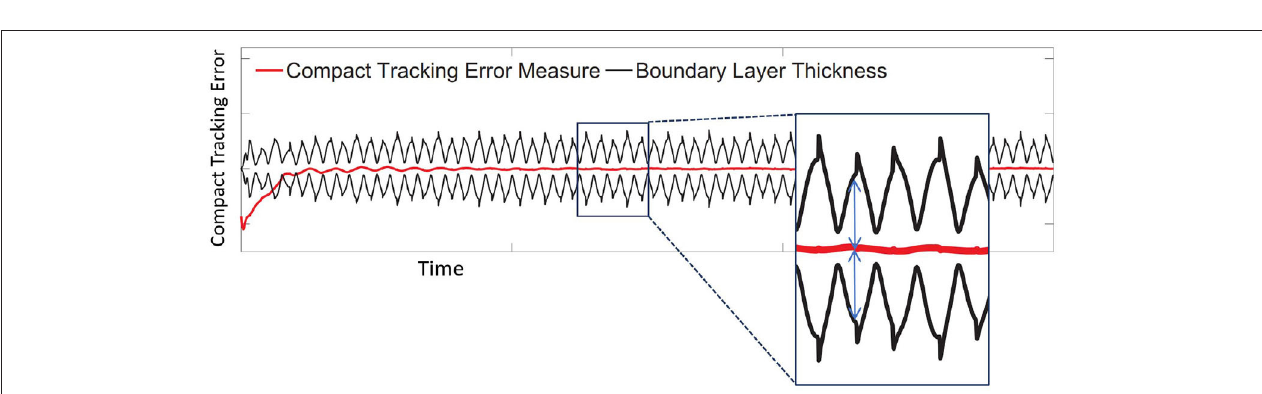
FIGURE 8 | Real-time computation and visualization of the run-time stability